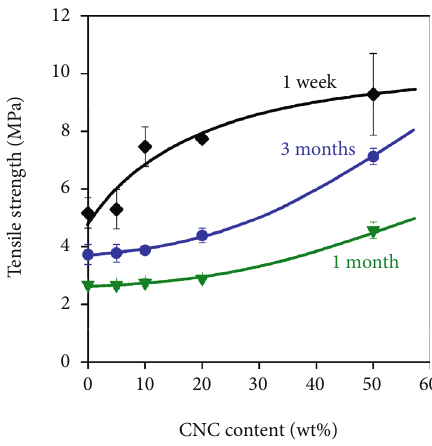
Figure 4: Characteristics over the physical and mechanical properties of CNC content across tensile